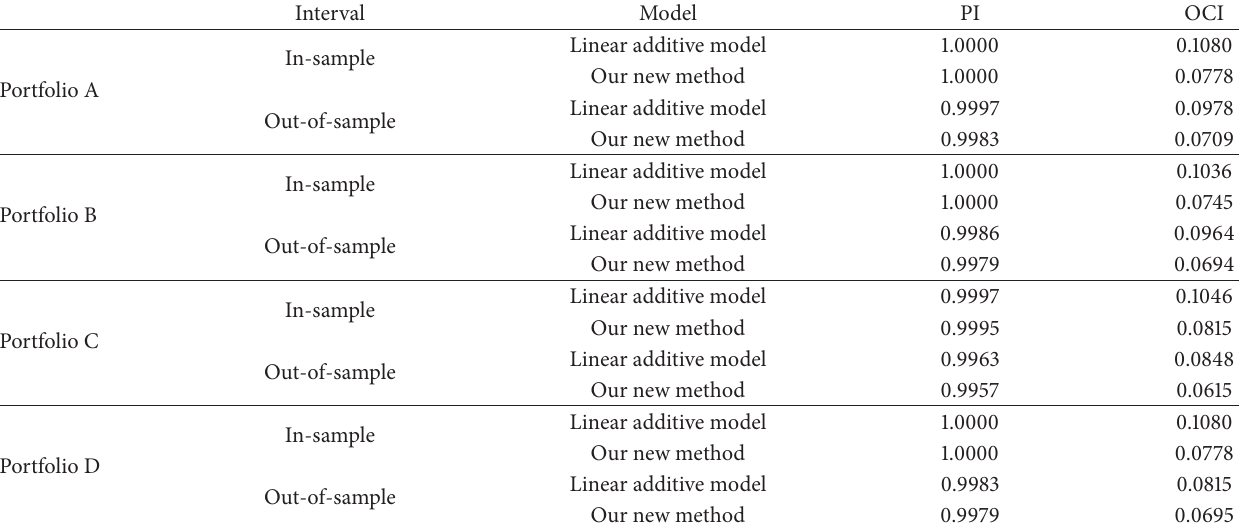
Table 7: Effectiveness of different methods of setting futures maintenance